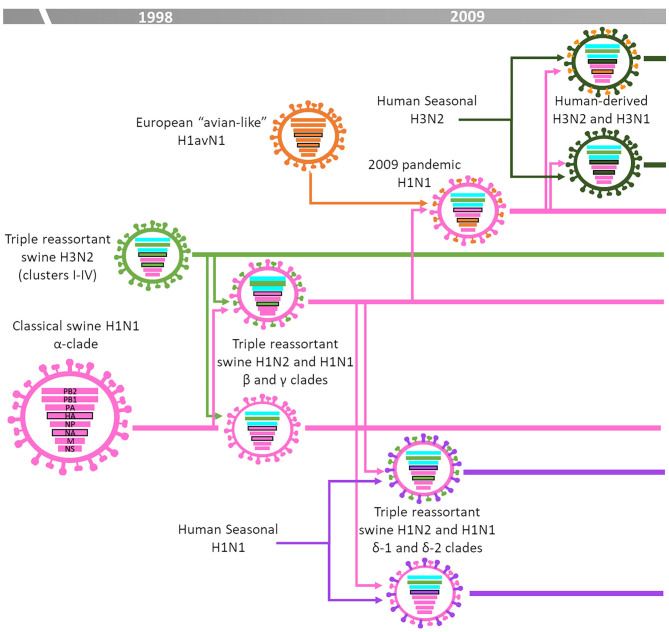
IAV-S epidemiology in the United States [based on (3)].